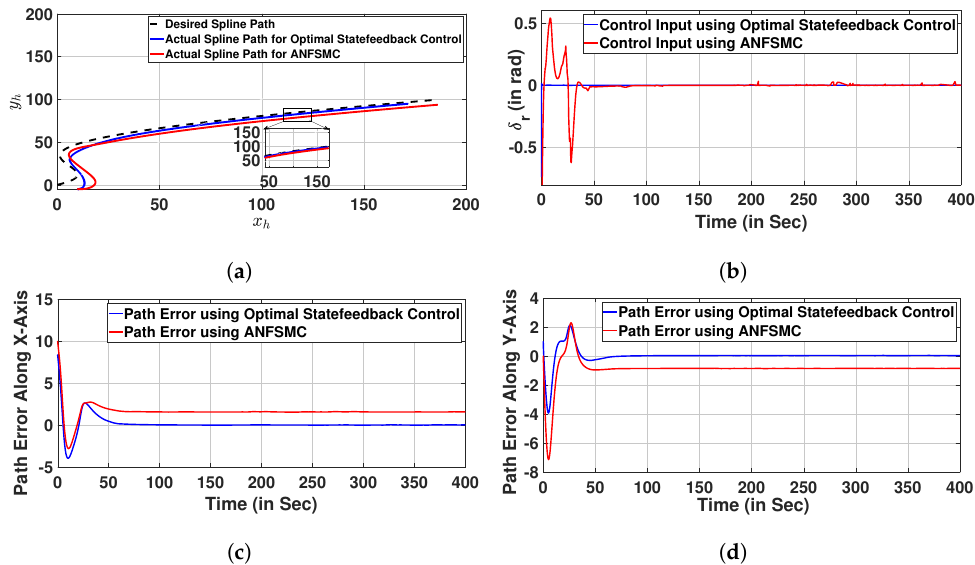
Figure 8. Path Following in Horizontal Plane for ± 10% Uncertainty. ( a ) Tracking of Desired Spline Path, ( b ) Control Input for a Spline Path, ( c ) x-axis path error for spline path, ( d ) y-axis path error for spline